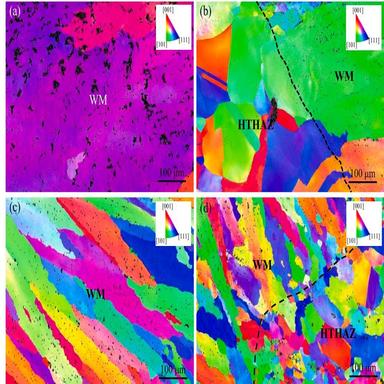
IPFz orientation maps show the microstructure of the WM and HTHAZ of the (top) IN600/WM and (bottom) WM/IN625 interfaces, respectively.